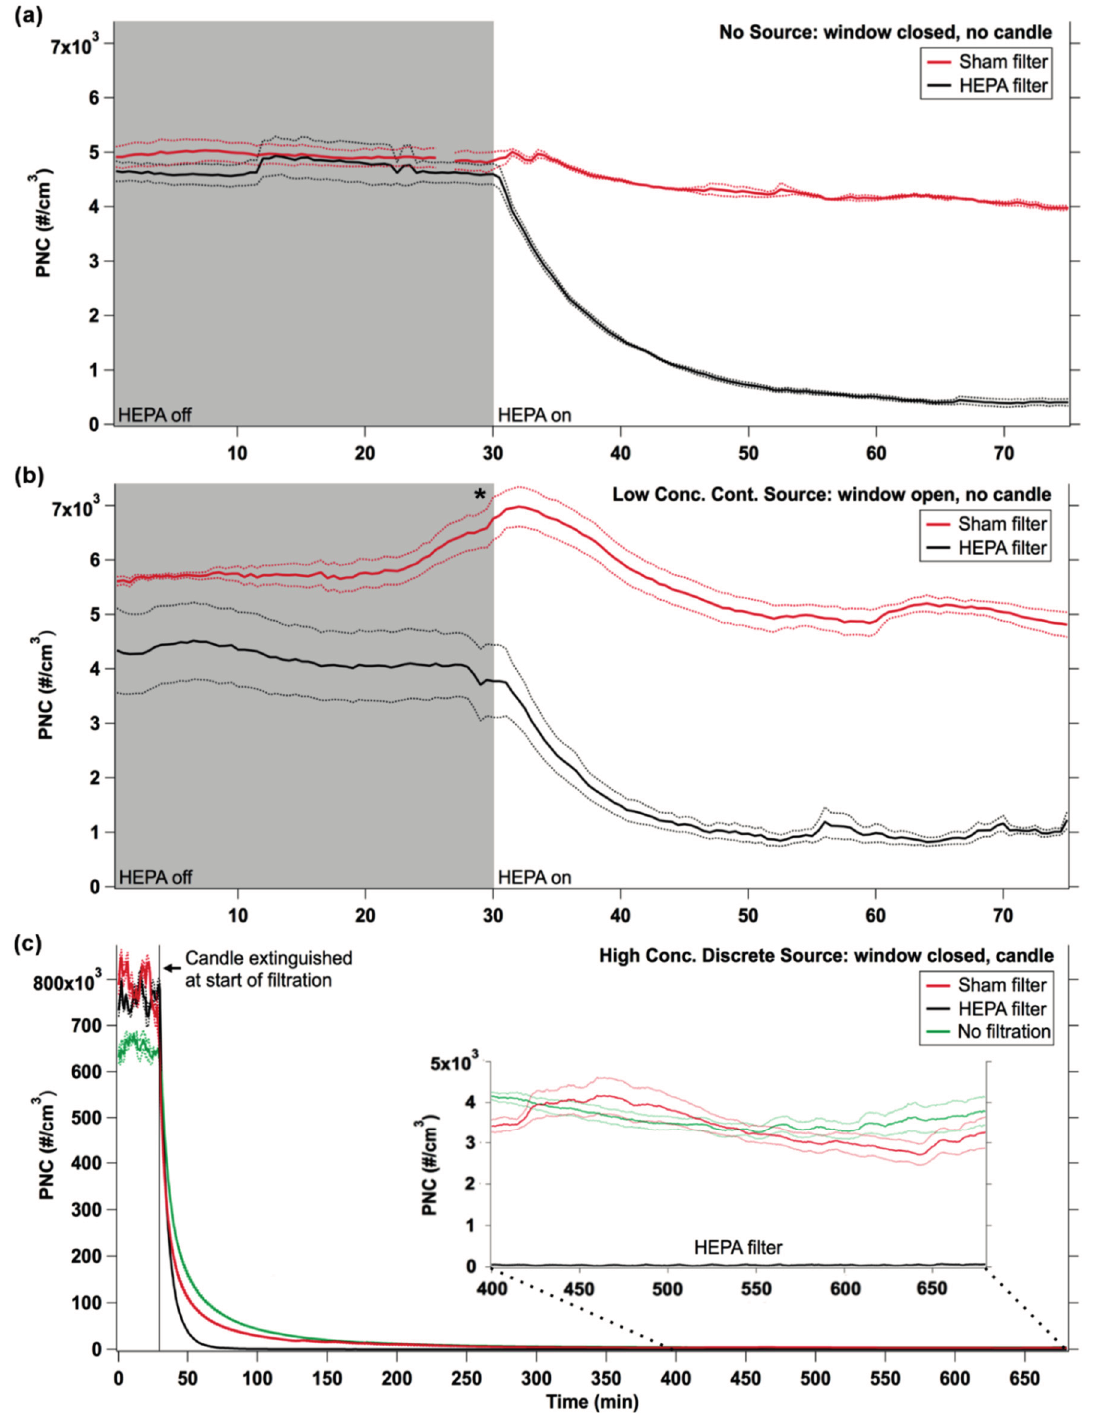
Figure A2. Results of HEPA and sham filtration experiments in an unoccupied bedroom for three PNC-source conditions: ( a ) no source, ( b ) low concentration, continuous source (ambient air through an open window), and ( c ) high concentration, discrete source (a lit candle that was extinguished at t = 30 min (note that HEPA was on at t = 0 min)). Solid lines represent the mean of three replicate experiments; dashed lines represent the standard error (SE). * The increase in PNC was due to an outdoor source that coincided with one of the three repetitions of the